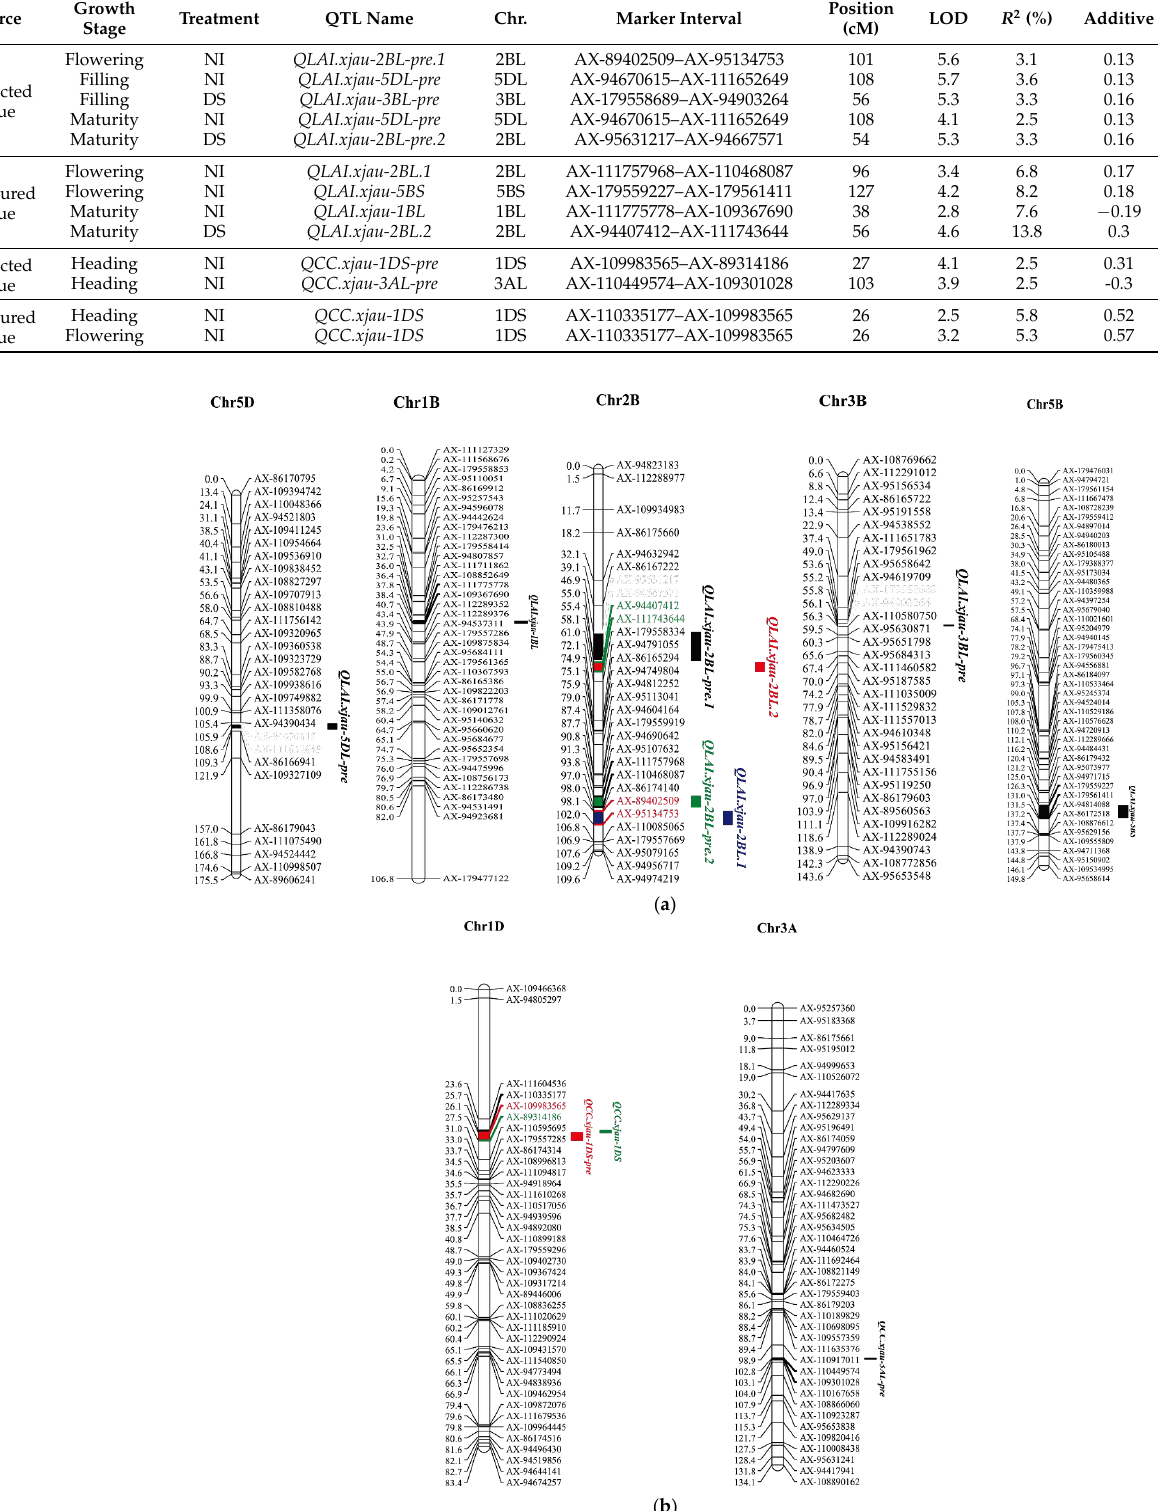
Table 6. Information on QTLs related to leaf area index (LAI) and chlorophyll content (CC) based on RIL population of cross Worrakatta × Berkut.